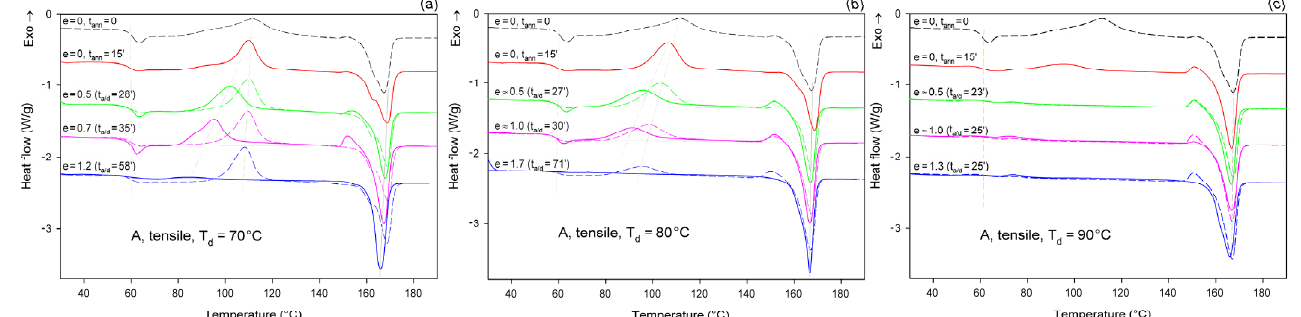
Figure 6. DSC heating scans of initially amorphous samples (A) drawn uniaxially at T d = 70 °C ( a ); 80 °C ( b ); and 90 °C ( c ), to the indicated true strain (solid lines). For each sample before deformation, a soak time of 15 min was used to equilibrate the temperature. The dashed lines represent samples that were annealed only at the respective temperature and time but were not deformed. The total residence time at the deformation or annealing temperature, t a/d , is indicated for each curve.